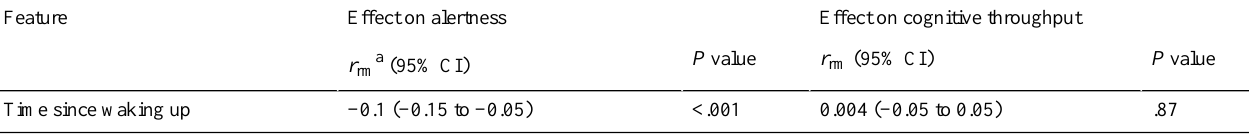
Table 8. Effect of homeostatic pressure on momentary alertness and cognitive throughput.